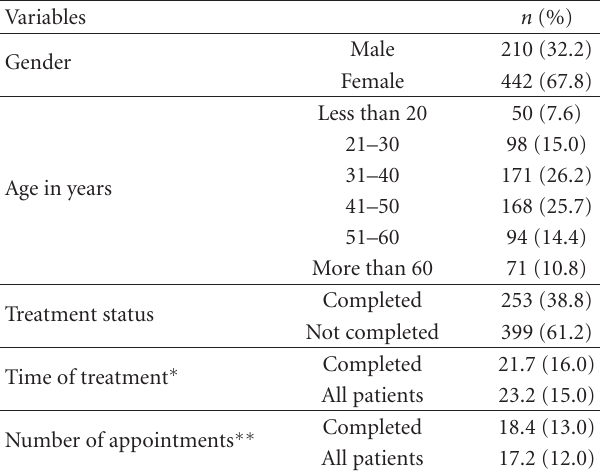
Table 1: Patient characteristics. Table 2: Distribution of complexity scores for clinical procedures ranked by judges, listed in descending order of the complexity